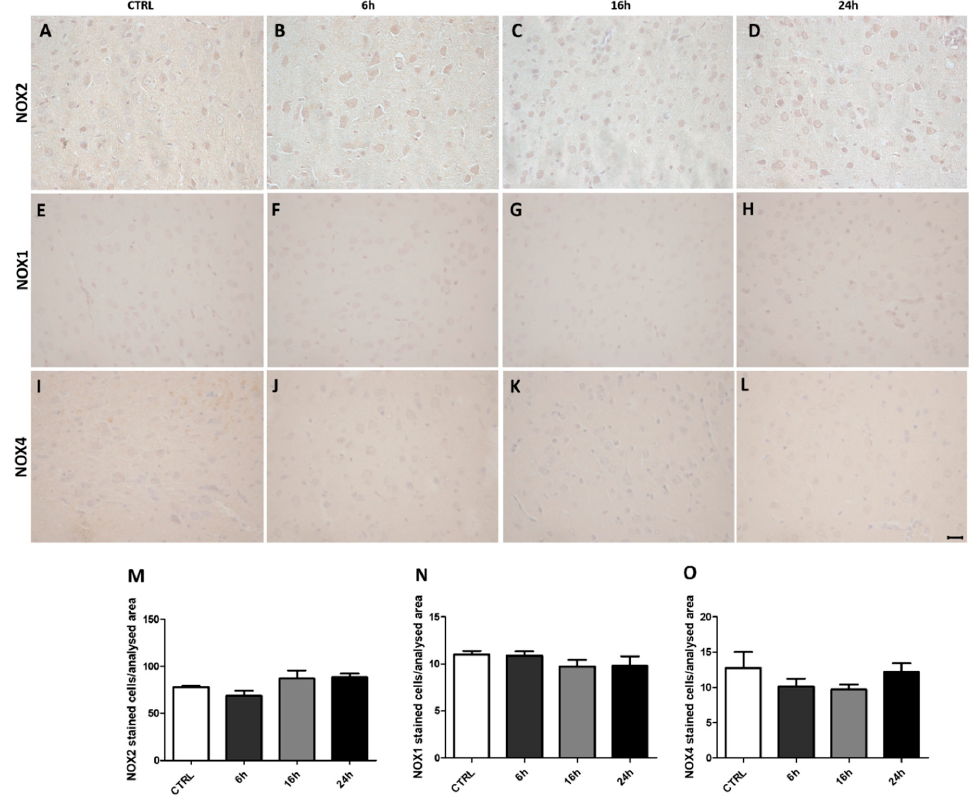
Figure 1. Nicotinamide adenine dinucleotide phosphate (NADPH) oxidase immunoreactivity is not affected by 3,4-Methylenedioxy- N -methylamphetamine (MDMA) administration . ( A – D